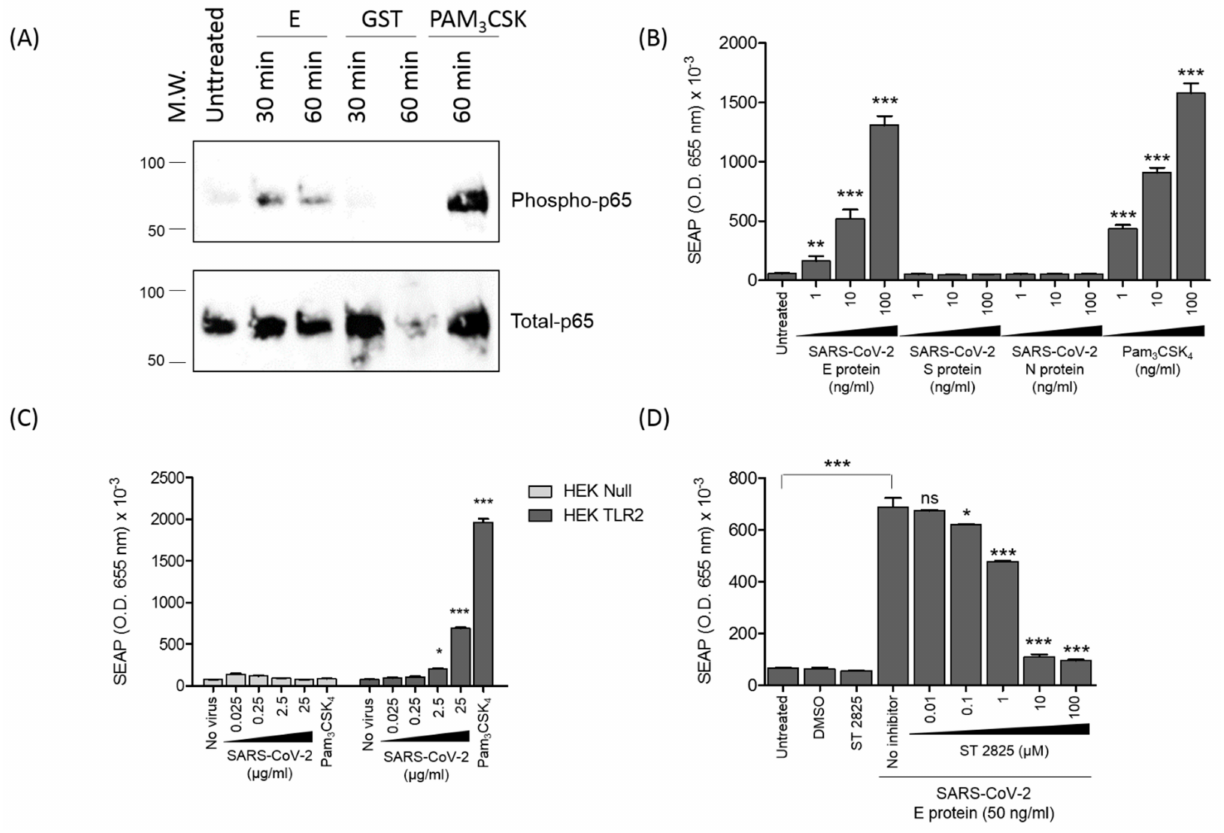
Figure 5. The E protein stimulates the activation of NF-kB. ( A ) HEK-TLR2 cells were stimulated with the E protein, GST or PAM3CSK4 for 30 or 60 min. Phosphorylation of P65 was analyzed by SDS-PAGE and Western blot by using specific anti-phospho-P65 ( upper panel ) or anti-total p65 antibodies ( lower panel ). ( B ) The HEK-TLR2 cell line, stably transfected with SEAP (secreted em- bryonic alkaline phosphatase), was treated with escalating concentrations of the envelope, spike or nucleocapsid protein or with PAM3CSK4 for 18 h, and SEAP activity was quantified in the cell super- natants. ( C ) HEK-blue TLR2 or HEK-blue null cells were stimulated with inactivated SARS-CoV-2 (0.025–25 µ g) and analyzed at 45 min as described in Figure 1B. ( D ) The HEK-TLR2 cell line was treated with the envelope protein in the presence of an increasing amount of the MyD88 inhibitor ST 2825 for 18 h, and SEAP activity was quantified in the cell supernatants. Statistical significance comparing different groups is denoted with * for p < 0.05, ** for p < 0.01 and *** for p < 0.001, while ns means